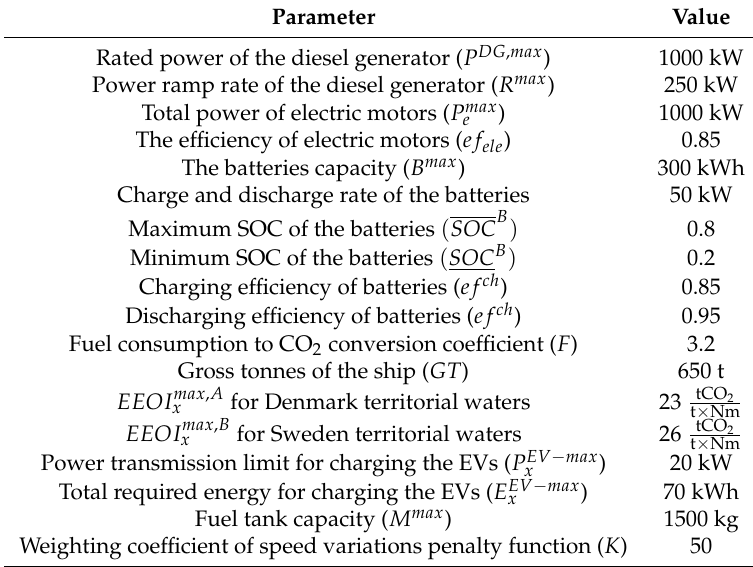
Table 2. Parameters of the energy system.